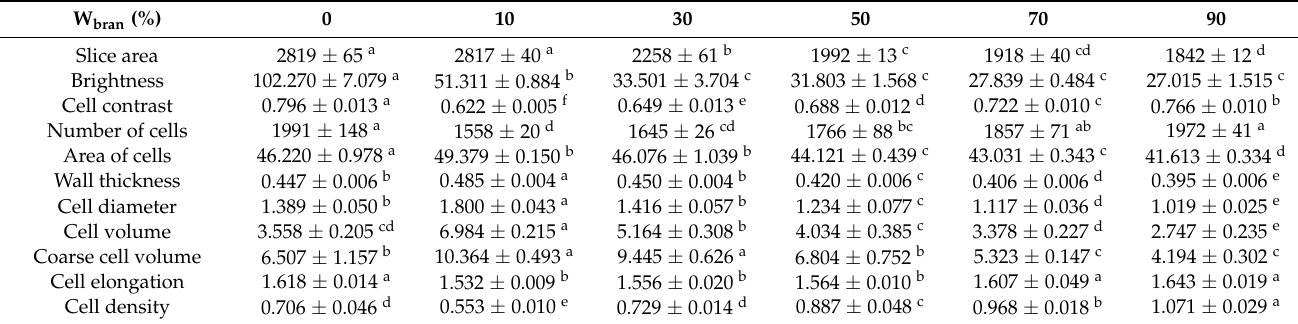
Figure 7. Effect of W bran on the raw and cell images of steamed bread slices (W bran : the weight proportion of TBBF in the blend four). Table 8. Effect of W bran on parameters values of Mixolab curves of mixed dough.